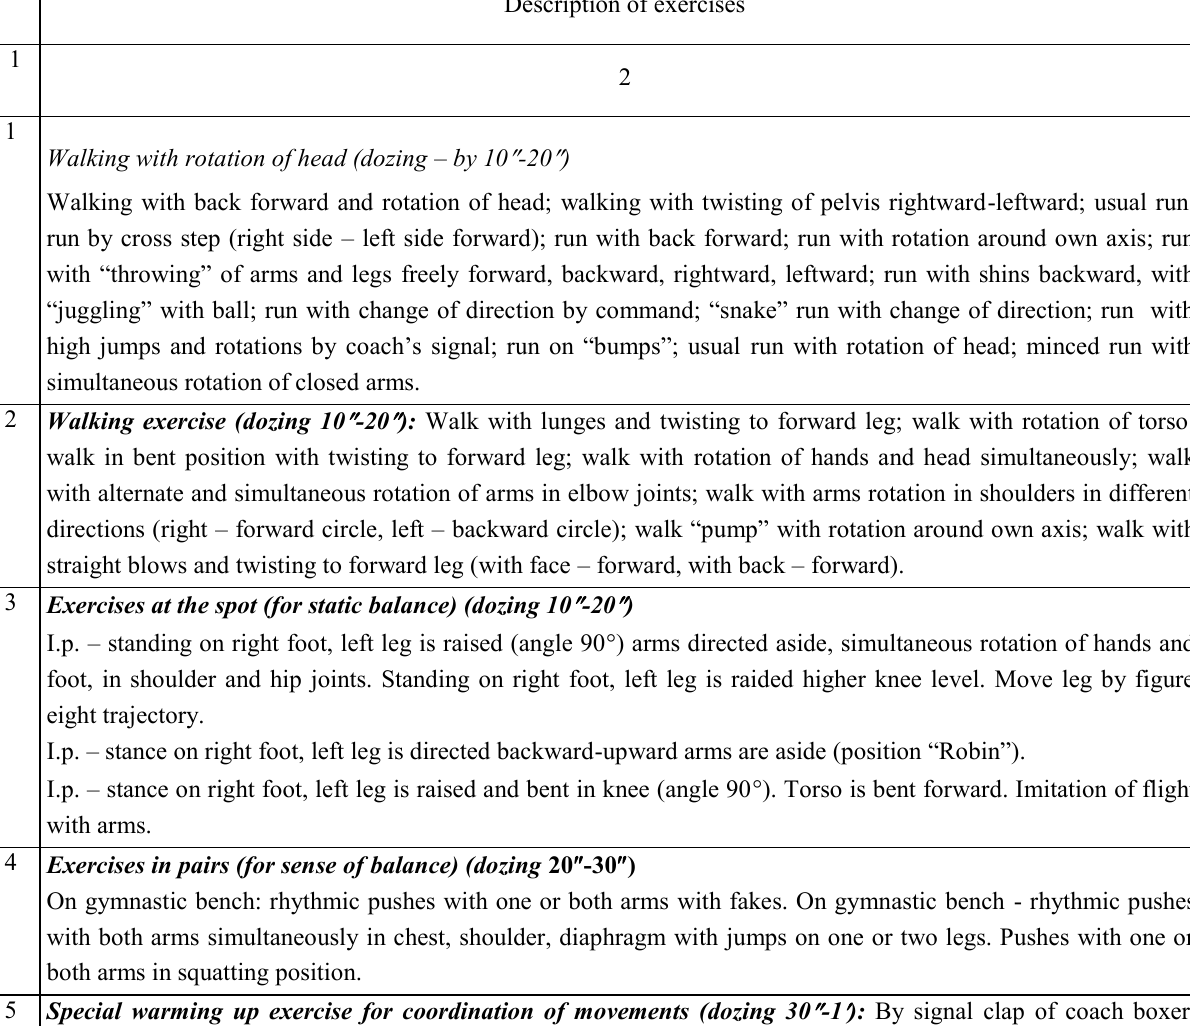
Approximate complex of exercises for coordination of movements and vestibular stability (for warming up part of training during 3 rd and 4 th months) Description of